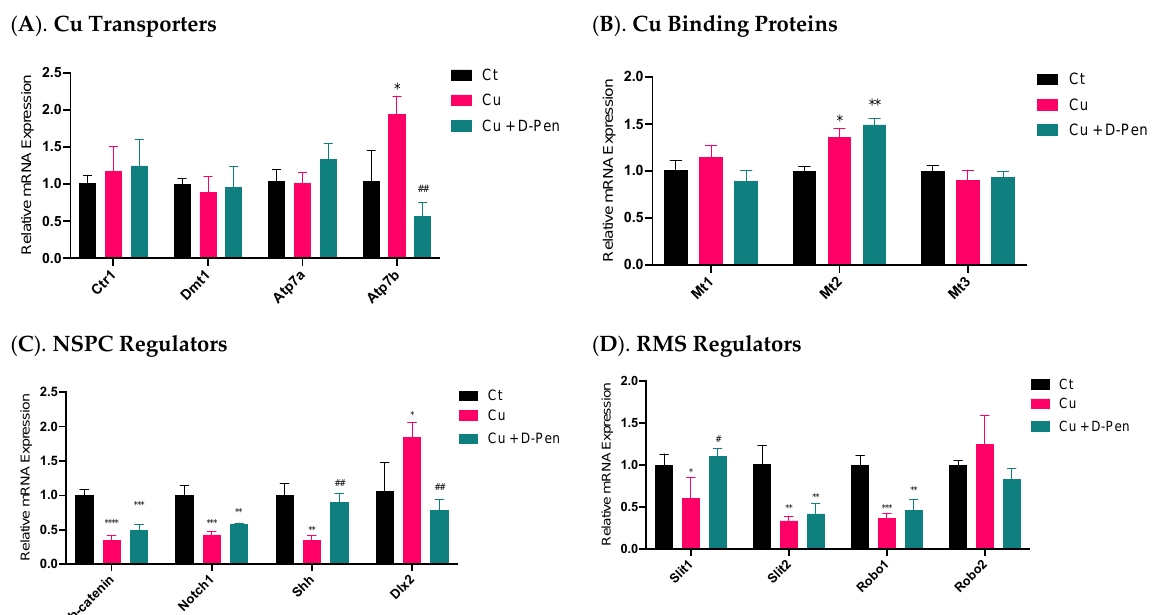
Figure 5. Expressions of mRNAs encoding critical modulators of Cu homeostasis and SVZ adult neurogenesis as affected by Cu status in culture medium. ( A ). Relative mRNA expressions of Cu transporting proteins in neurospheres, including Ctr1, Dmt1, Atp7a, and Atp7b. ( B ) Relative mRNA expressions of Cu binding proteins in neurospheres, including Mt1, Mt2, and Mt3. ( C ). Relative mRNA expressions of modulators of adult NSPCs in adult SVZ, including b-catenin, Notch1, Shh, and Dlx2. ( D ) Relative mRNA expressions of neuroblast migration modulators in adult RMS, including Slit1, Slit2, Robo1, and Robo2. For panel A-D, data represent mean ± SD, n = 3/group. * p < 0.05, ** p < 0.01, *** p < 0.001, **** p < 0.0001, as compared with the control group; # p < 0.05, ## p < 0.01, as compared with the Cu treatment group; 10 µM Cu and 20 µM D-Pen were used as previously demonstrated.